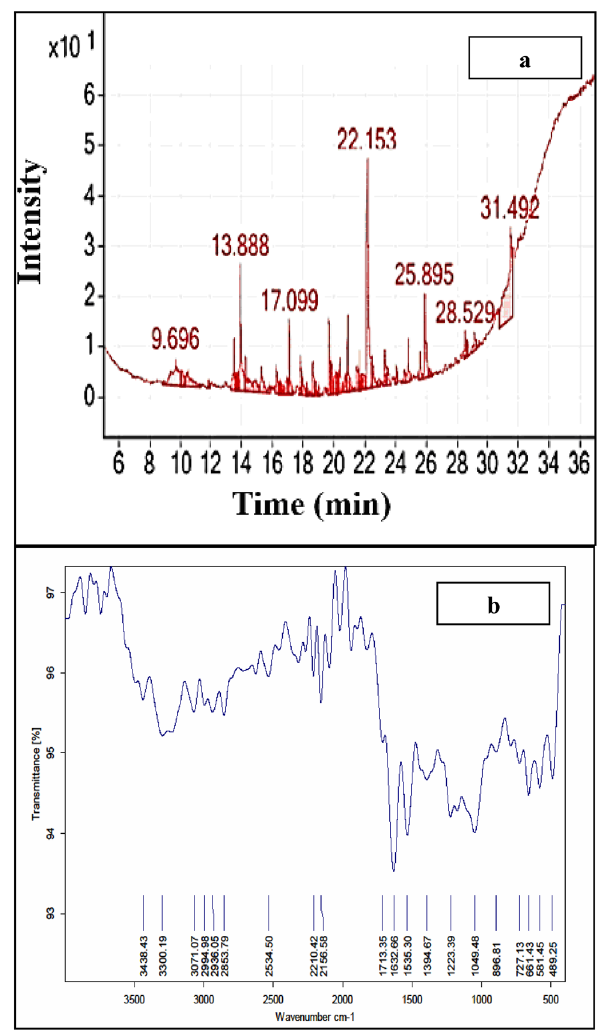
Figure 5. Chemical analysis of the partially purified extracted biosurfactant. ( a ) Gas chromatography–mass spectrometry (GC–MS) analysis. ( b ) Fourier transform infrared (FTIR) spectroscopy